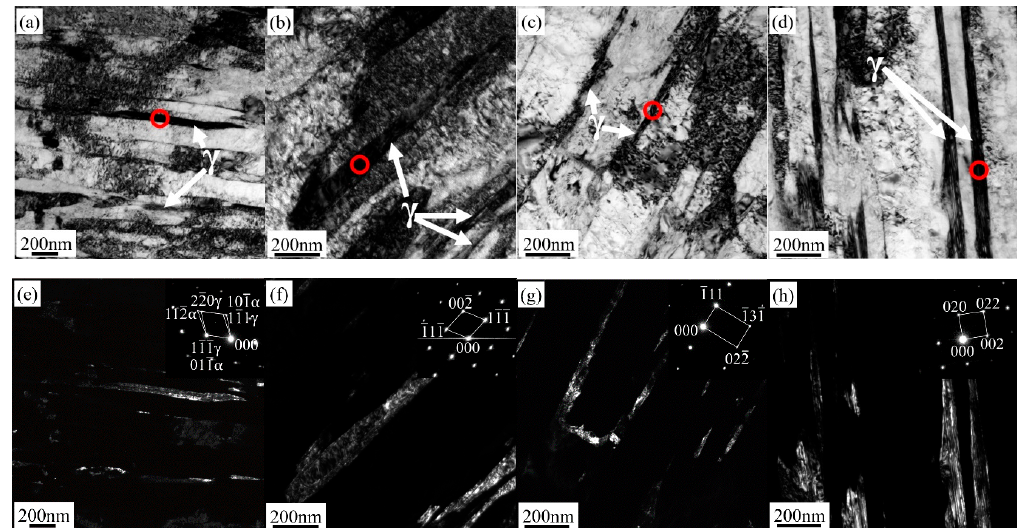
Figure 7. Combined phase map and grain boundaries of ( a ) 1000-P; ( b ) 1020-P; ( c ) 1040-P; and ( d ) 1060-P (red, blue and black represent the retained austenite, martensite and boundaries with misorientation >10 o , respectively); ( e ) average equivalent circle diameter of the retained austenite (RA).